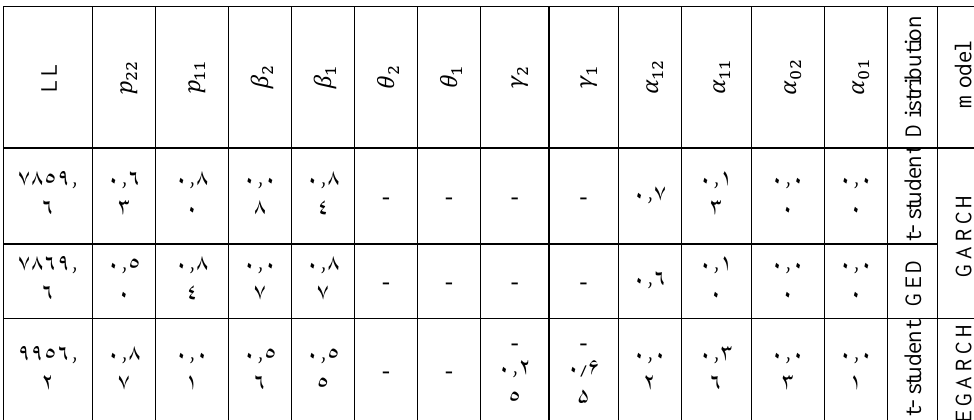
Table 10. MRS–GARCH models of the investment